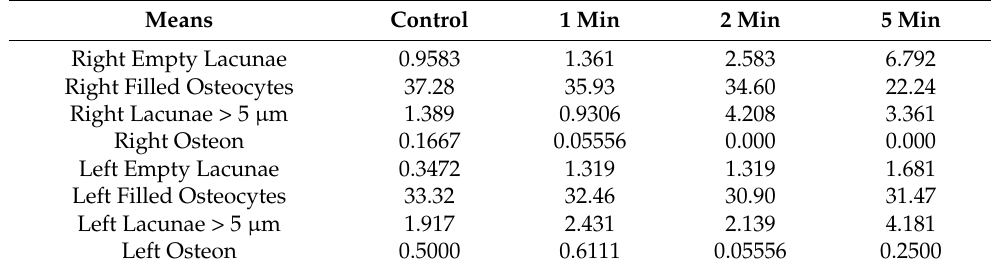
Table 1. Empty lacunae, filled osteocytes, lacunae >5 µ m, and osteon numbers in a 10,000 µ m 2 area. Means Control 1 Min Right Empty Lacunae